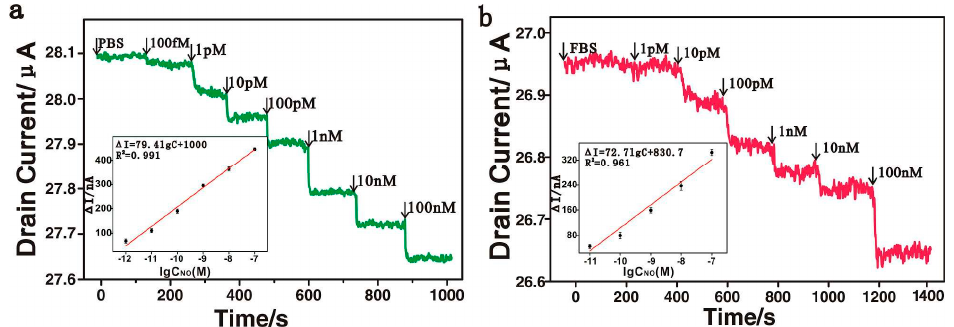
Figure 11. ( a ) Real-time electrical measurement at different concentrations of NO solution in PBS. Inset: the response of the rGO/FGPCs FET biosensors to NO at a series of concentrations (1, 10, 100 pM and 1, 10 and 100 nM) in PBS. ( b ) Real-time electrical measurement at different concentrations of NO solution in the cell medium. Inset: the response of the rGO/FGPCs FET biosensors to NO at a series of concentrations (10, 100 pM and 1, 10 and 100 nM) in fetal bovine serum. Reprinted with permission from [78]. Copyright 2016 American Chemical Society.